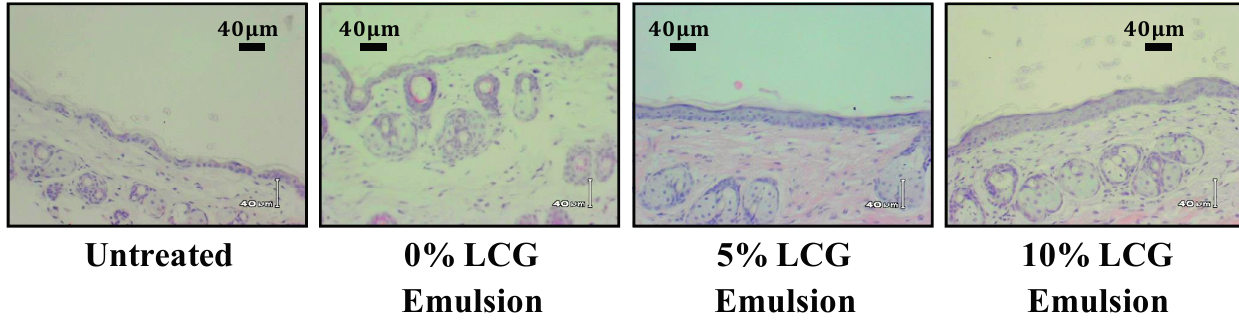
Figure 2. Liquid crystal gel (LCG) concentration-dependent increase in epidermal thickness is visible even at concentrations as low as 5% and 10% LCG as shown in these images of hematoxylin and eosin (H&E)-stained mouse skin.